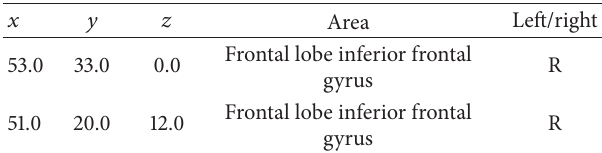
Table 3: Coordinates of Talairach’s Atlas ( 𝑥/𝑦/𝑧 axis) resulting from hypometabolic contrast SPM- 𝑡 analysis of atypical Cogan’s syndrome group versus control group.